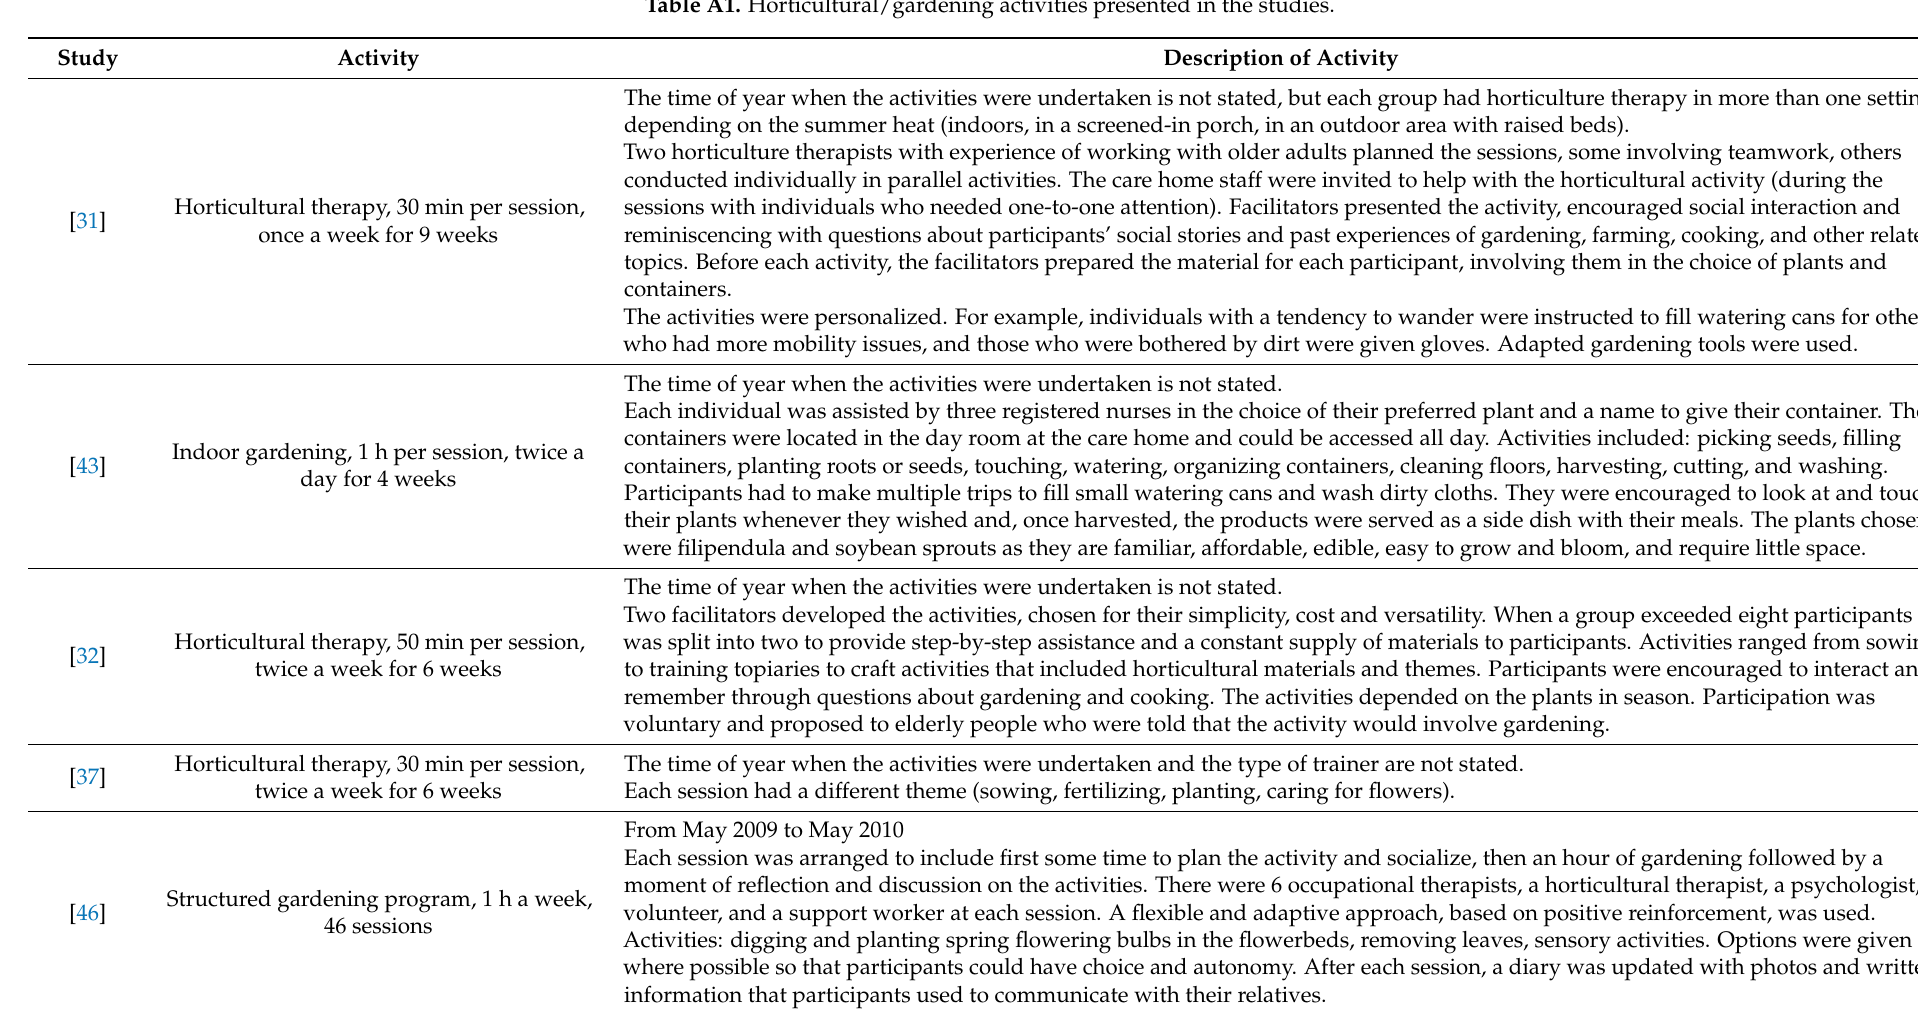
Table A1. Horticultural/gardening activities presented in the